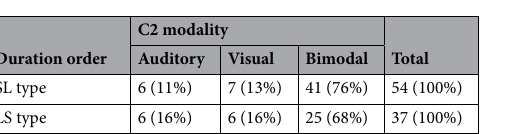
Table 3. Duration order specificity and C2 modality sensitivity in D2-responsive